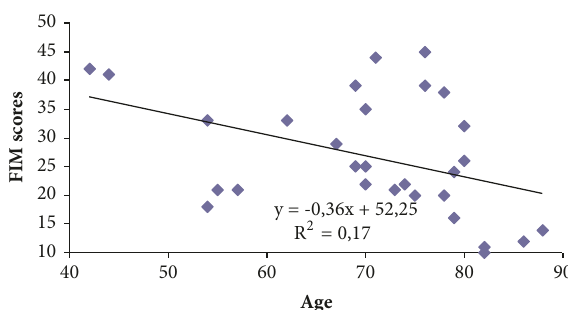
Figure 2: Correlation between patients’ age and change of FIM scores during